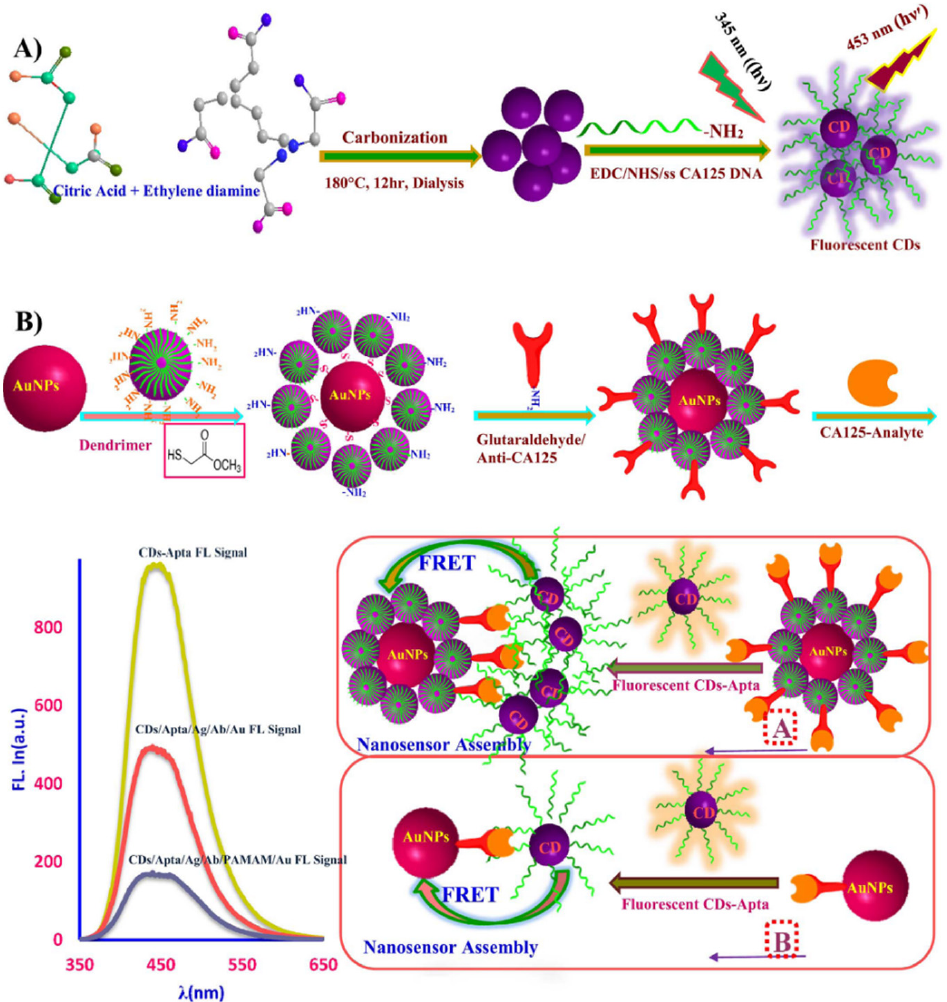
Figure 2. The mechanism for the FRET-based detection system: in the first part, the fluorescent CDs were conjugated to DNA ( A ); and then the CDs-Apta fluorescence response was quenched by AuNPs-PAMAM-Ab through FRET in the presence of CA125 analyte ( B ) [53]. Copyright 2017, Elsevier. For other biological signals, Khan et al. fabricated a ZnO@CDs electrode with